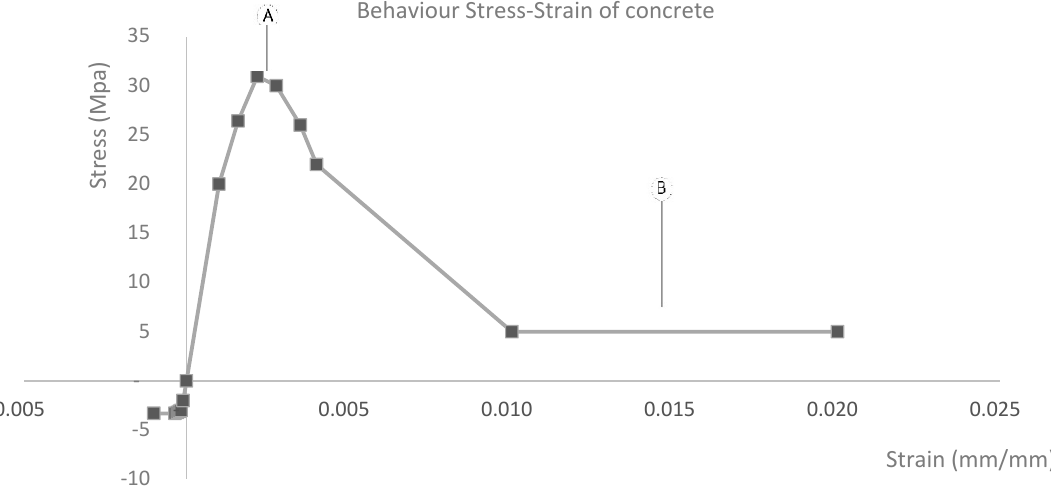
Figure 6. Stress-Strain of concrete from the numerical model.